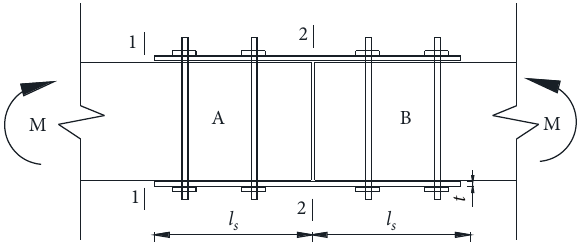
Figure 16: Pure bending section of the connection with steel plate hoop and